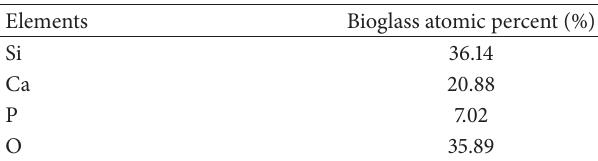
Table 3: EDS analysis of bioglass